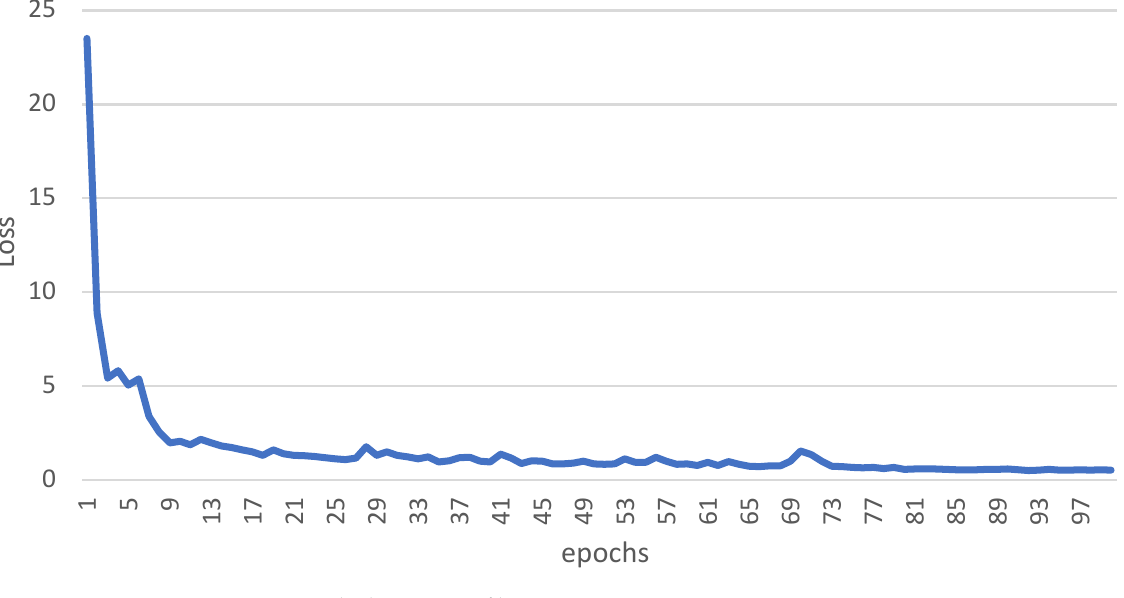
Figure 8. The loss curve of basic training.